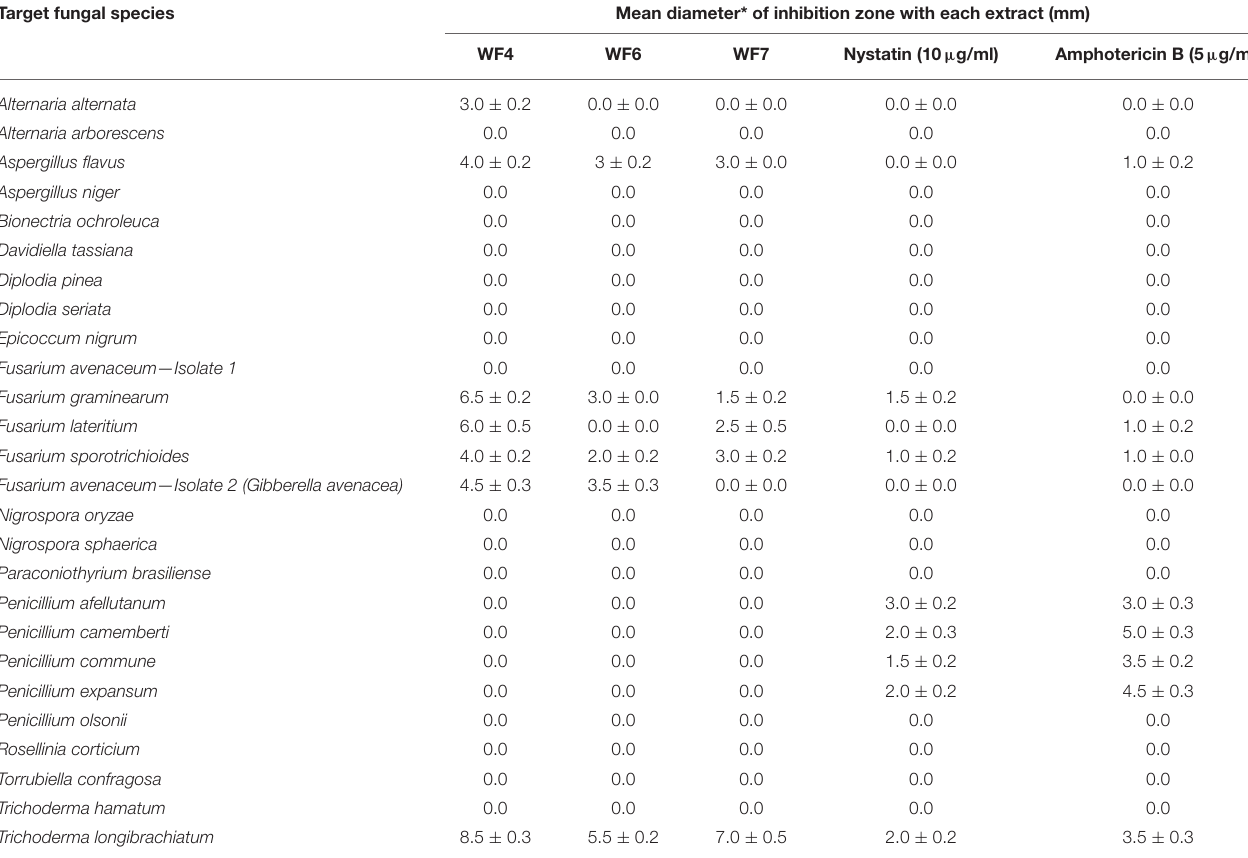
TABLE 1 | Effect of endophyte extracts on the growth of a diversity of fungal species. Target fungal